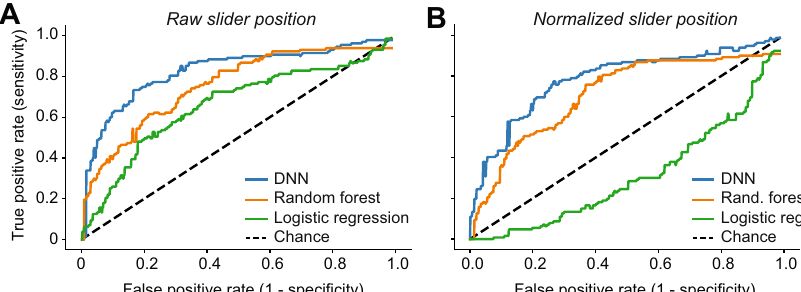
Fig. 3 Tinnitus vs malingerer classi fi er performance using minimum masking level (MML) slider time-series data. A The original time- series data with ROC AUC = 0.84, 0.77, and 0.67 and accuracies of 77%, 65%, 49% accuracy respectively for a DNN, Random Forest, and Logistic Regression. B The same classi fi ers on time-series data where the MML value is subtracted out for each participant with an ROC AUC = 0.79, 0.72, and 0.31 and 77.4%, 65%, 49% accuracy respectively.